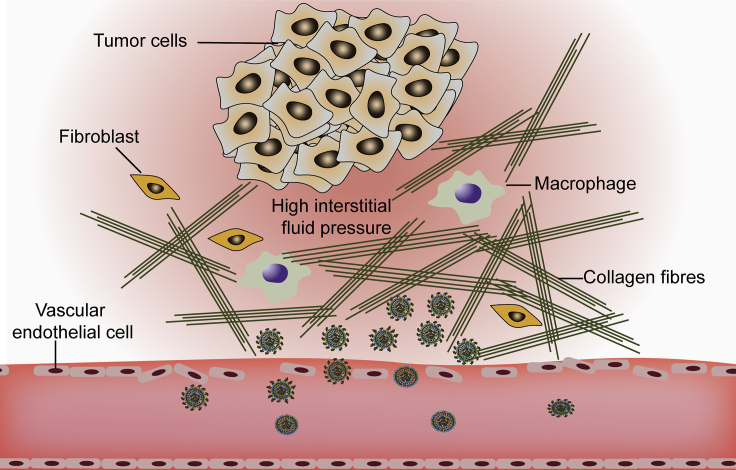
Illustration of Tumor MicroenvironmentVascular abnormalities and lack of lymphatic drainage allow CLs to accumulate in tumor, but dense extracellular matrix and increased interstitial fluid pressure prevent the particles from penetrating deeper into the tumor.